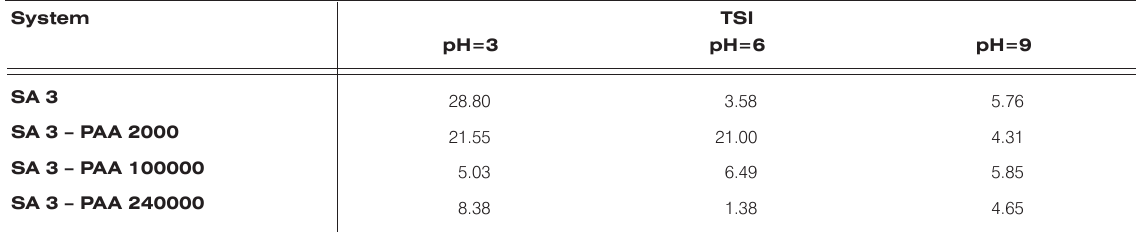
Table 1. The TSI indexes for SA 3 suspension in the absence and presence of polyacrylic acid.